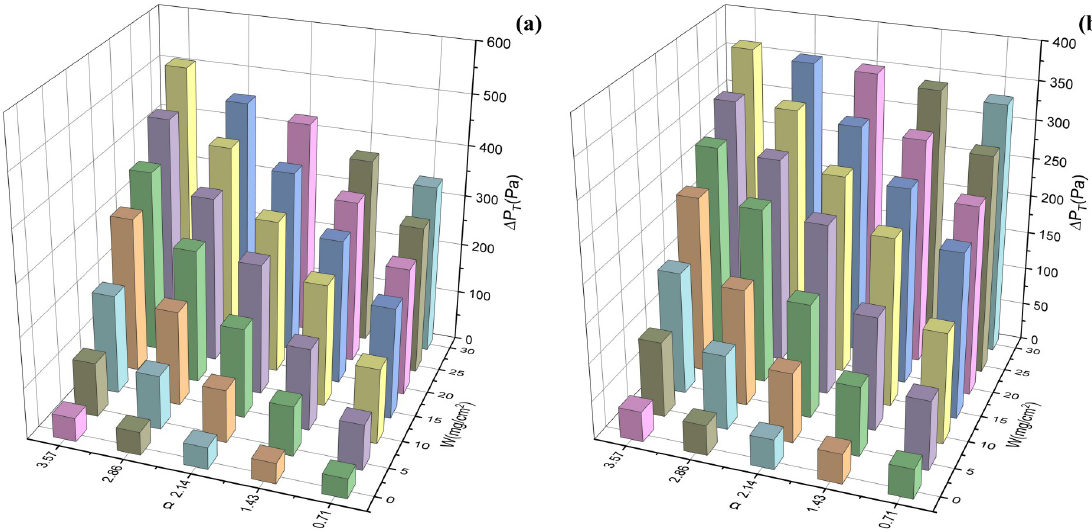
Fig 14. Changes in simulated total pressure drops with α and W of the filters (a) V-shaped filters, (b) U-shaped filters.